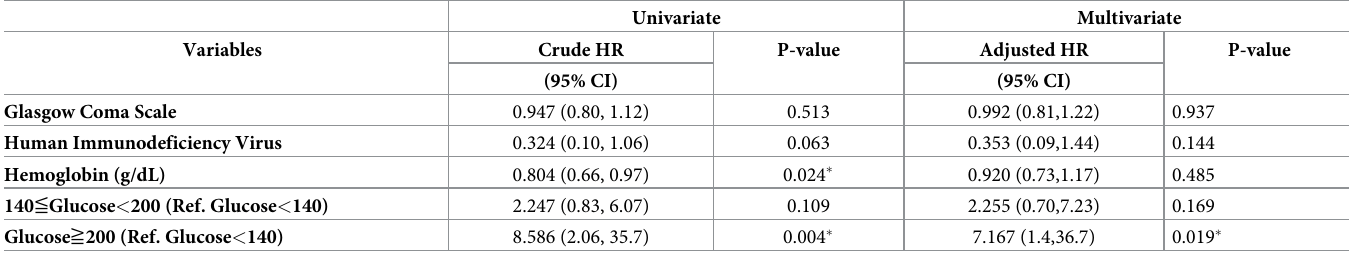
Table 2. Univariate and multivariate Cox proportional hazards analysis for the outcome of 3-year